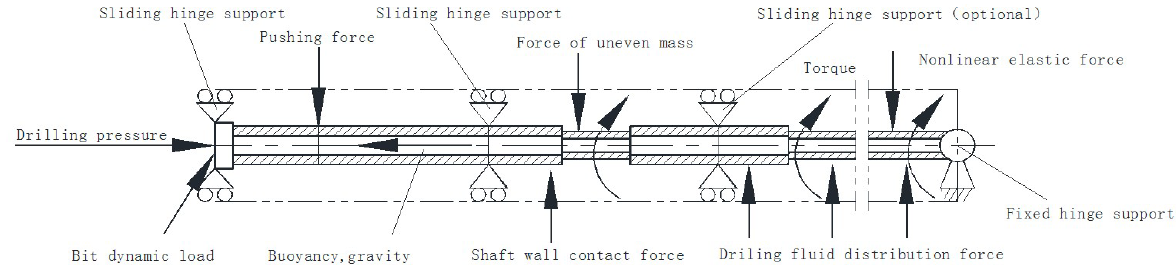
Figure 1. Dynamics model of Rotary Steering Drilling System